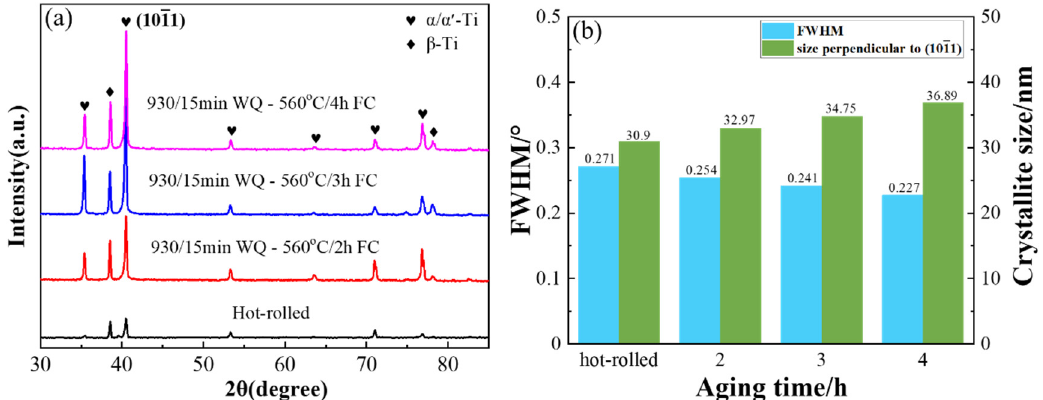
Figure 7. ( a ) XRD patterns of TC4 alloy aged sheets ( b ) the FWHM of (101 (cid:3364) 1) and the calculated size.